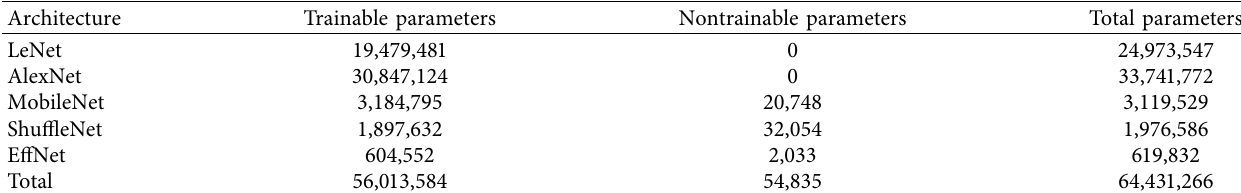
Table 6: Parameters of the convolutional neural networks